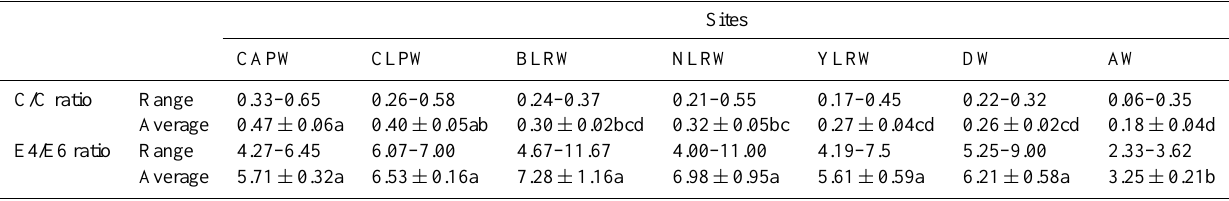
Table 2. Average values of C/C and E4/E6 ratios in surface ponds from contrasting wetlands in the Sanjiang Plain during the growing season of 2010.